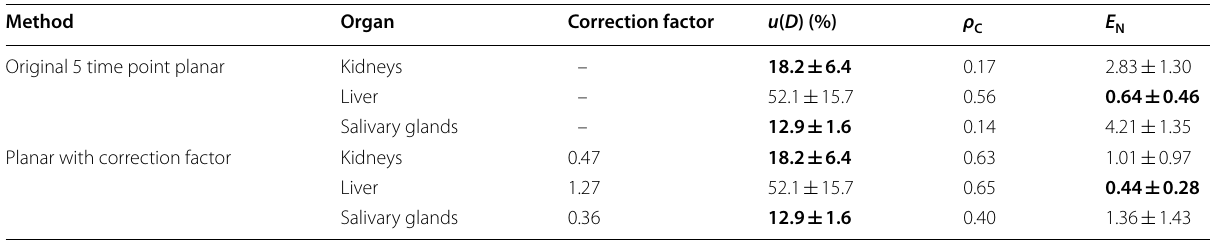
Mean SD values are given. Parameters that meet requirements are marked in bold ±